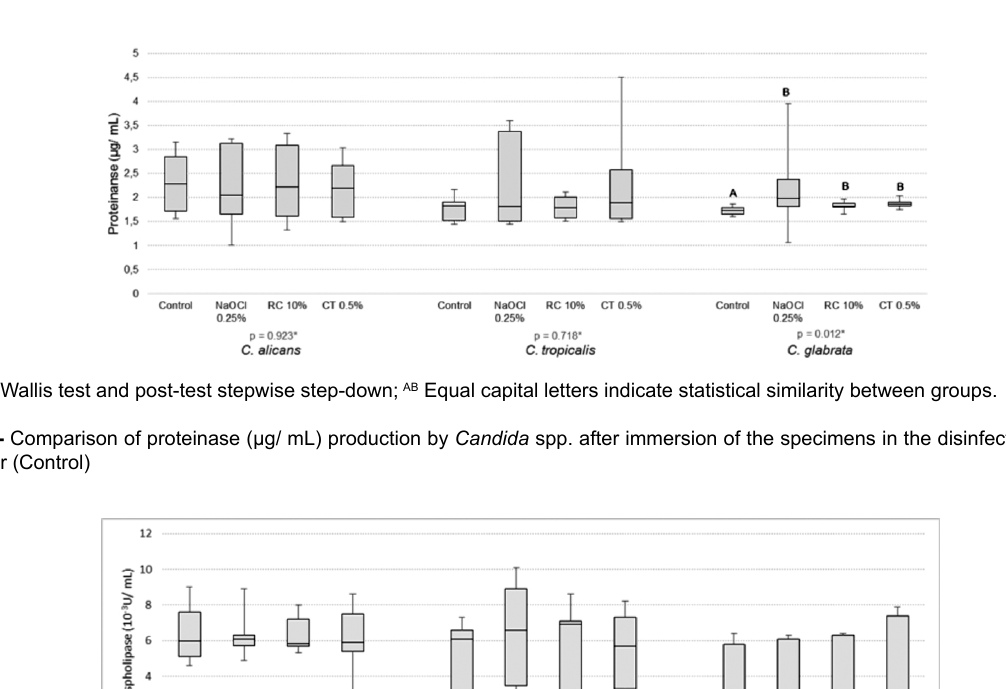
Figure 2- Comparative analysis of metabolic activity (absorbance 492 nm) of Candida spp. after immersion of the specimens in the disinfectant and control solutions